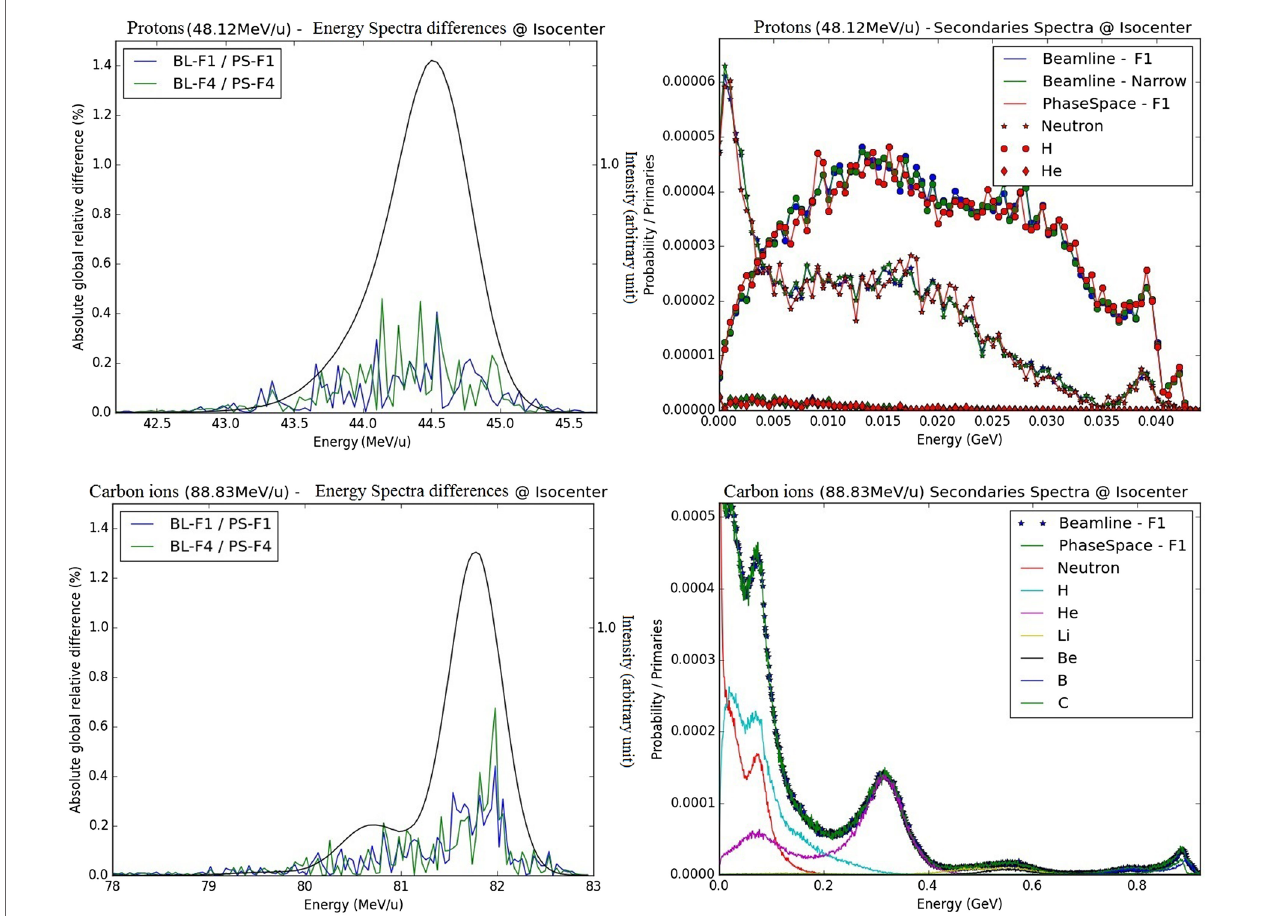
FigUre 5 | Fluence distributions for protons and carbon ions at the isocenter in air – vertically integrated profiles: on the left panels, vertically integrated profiles (projections of X profiles) from Bl and Ps approaches are displayed for foci 1 and 4 in semi-logarithmic scale; on the right panels, absolute relative differences between lateral distributions from Ps and Bl approaches are displayed for foci 1 and 4 of the smallest energy (blue/red) together with their respective shapes (black); the upper panel corresponds to protons (48.12 MeV/u), the bottom panel corresponds to carbon ions (88.83 MeV/u).